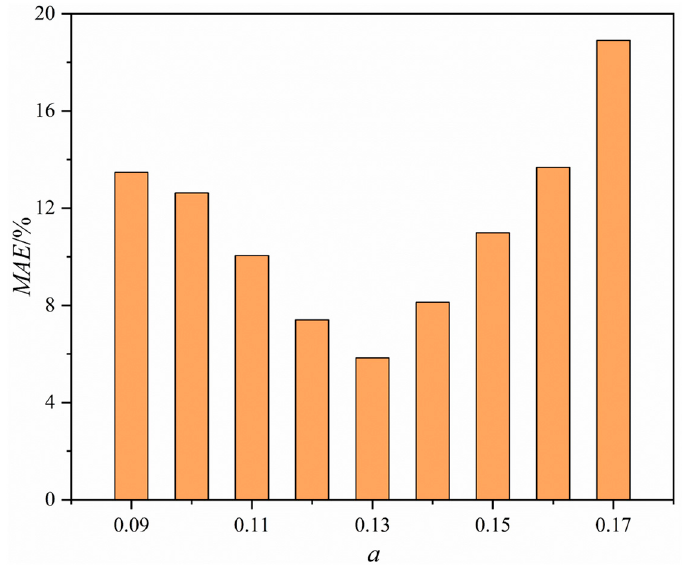
Figure 5. Mean absolute error ( MAE ) of the comparison between the water area extracted by MODIS product through the dynamic threshold a and that extracted by Landsat/Sentinel-2 product.